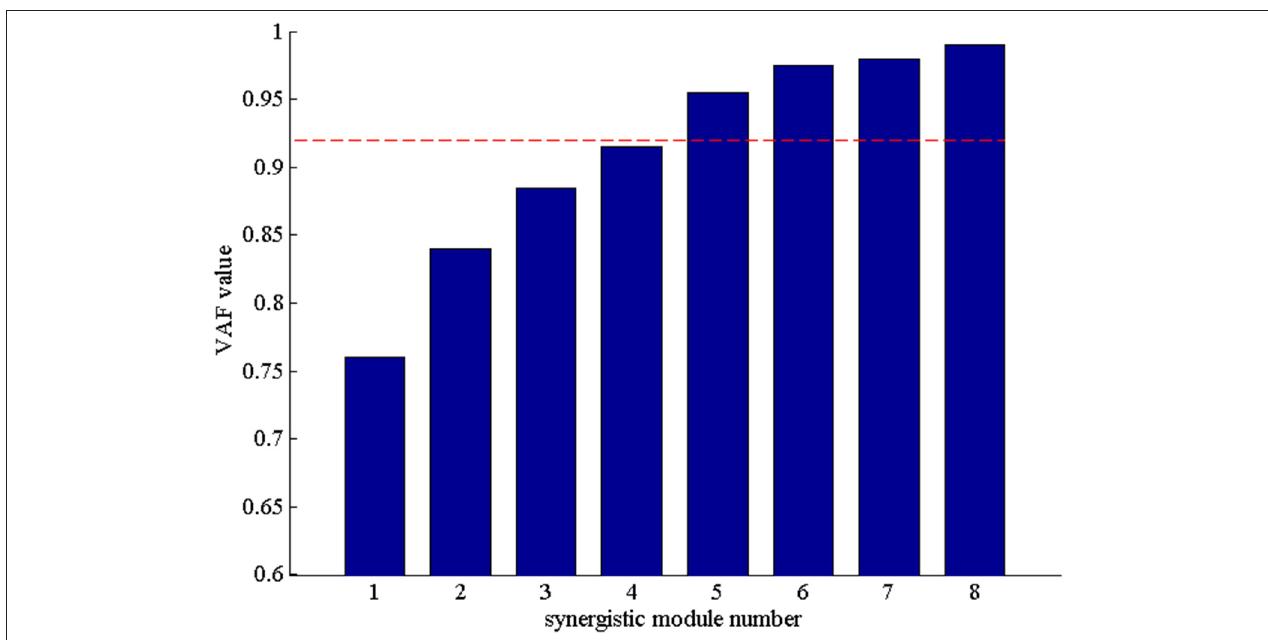
FIGURE 5 | The VAF values with the number of the synergy modules increasing. The red dash denoted that VAF value is 0.92.